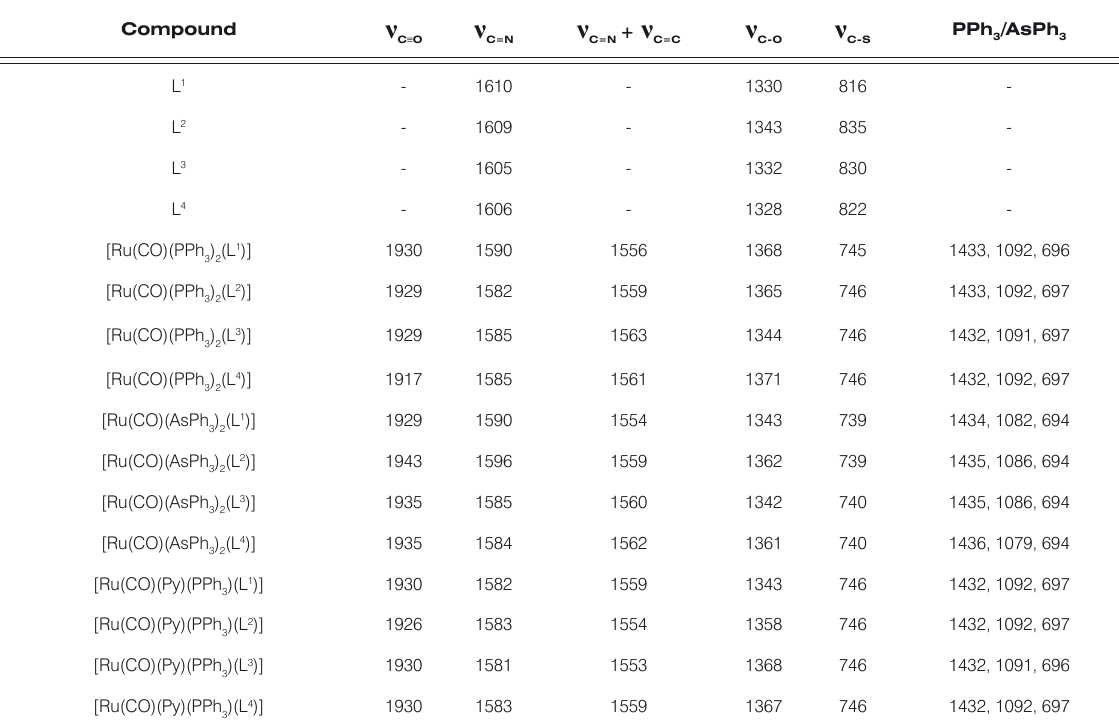
Table 2. IR absorption frequencies (cm -1 ) of free ligands and their ruthenium(II) chalcone thiosemicarbazone